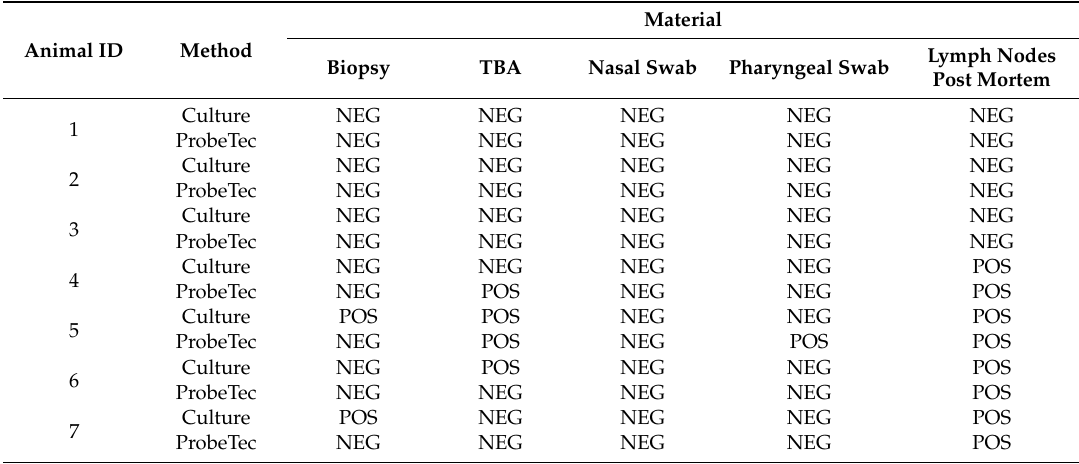
Table 1. A comparison of MTBC isolation in samples obtained from di ff erent material collected from living and post mortem European